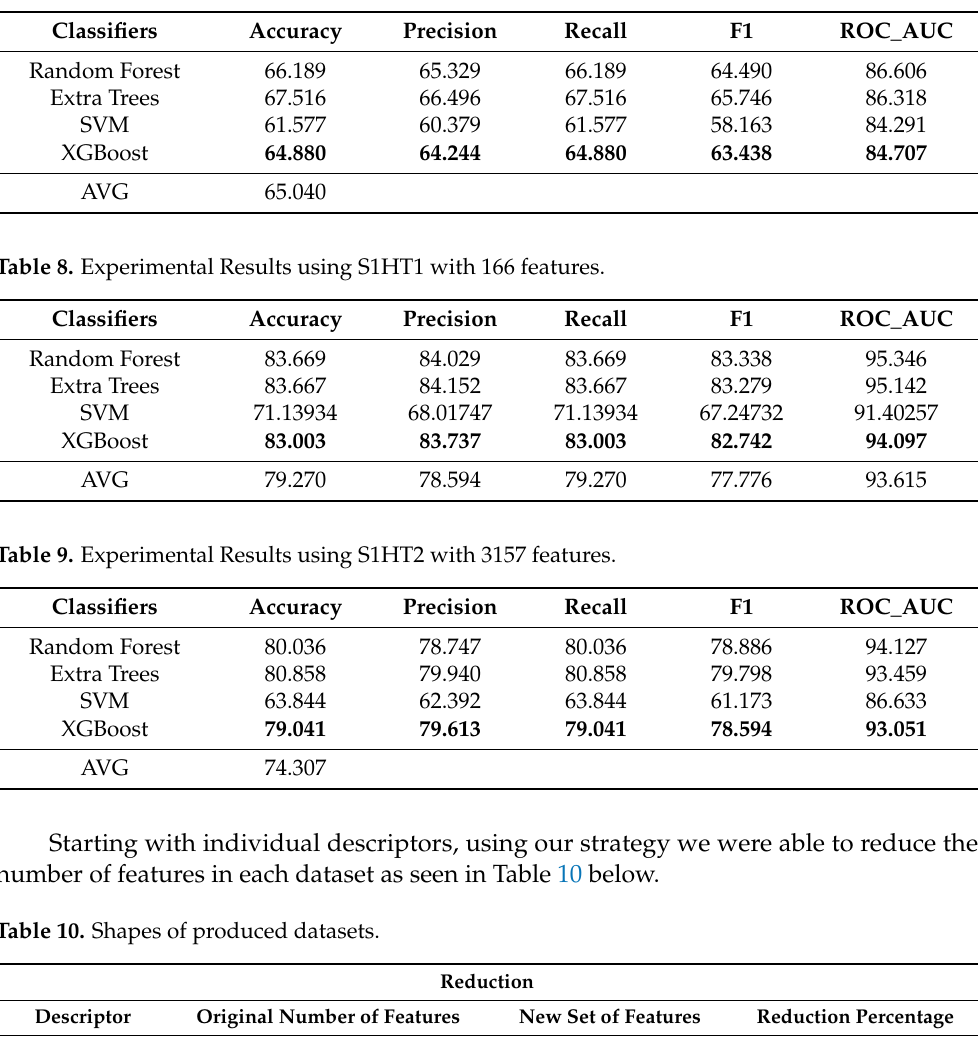
Table 7. Experimental Results using S_CNV 486 features.